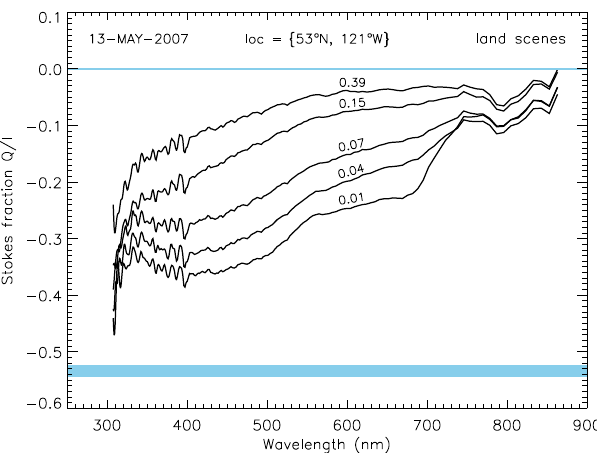
Figure 9. Spectra of Q/I for scenes over (vegetated) land. Cloud Fig. 9. Spectra of Q/I for scenes over (vegetated) land. Cloud presence varies from one presence varies from one scene to the other. For the rest the scene scene to the other. For the rest the scene properties are comparable. As before, the numbers properties are comparable. As before, the numbers indicate effective indicate effective cloud fractions. For low effective cloud fractions the spectra show the cloud fractions. For low effective cloud fractions the spectra show the chlorophyll “bump” at ∼ 500nm and the vegetation red edge at chlorophyll “bump” at ∼ 500nm and the vegetation red edge at ∼ 700nm . ∼ 700nm.